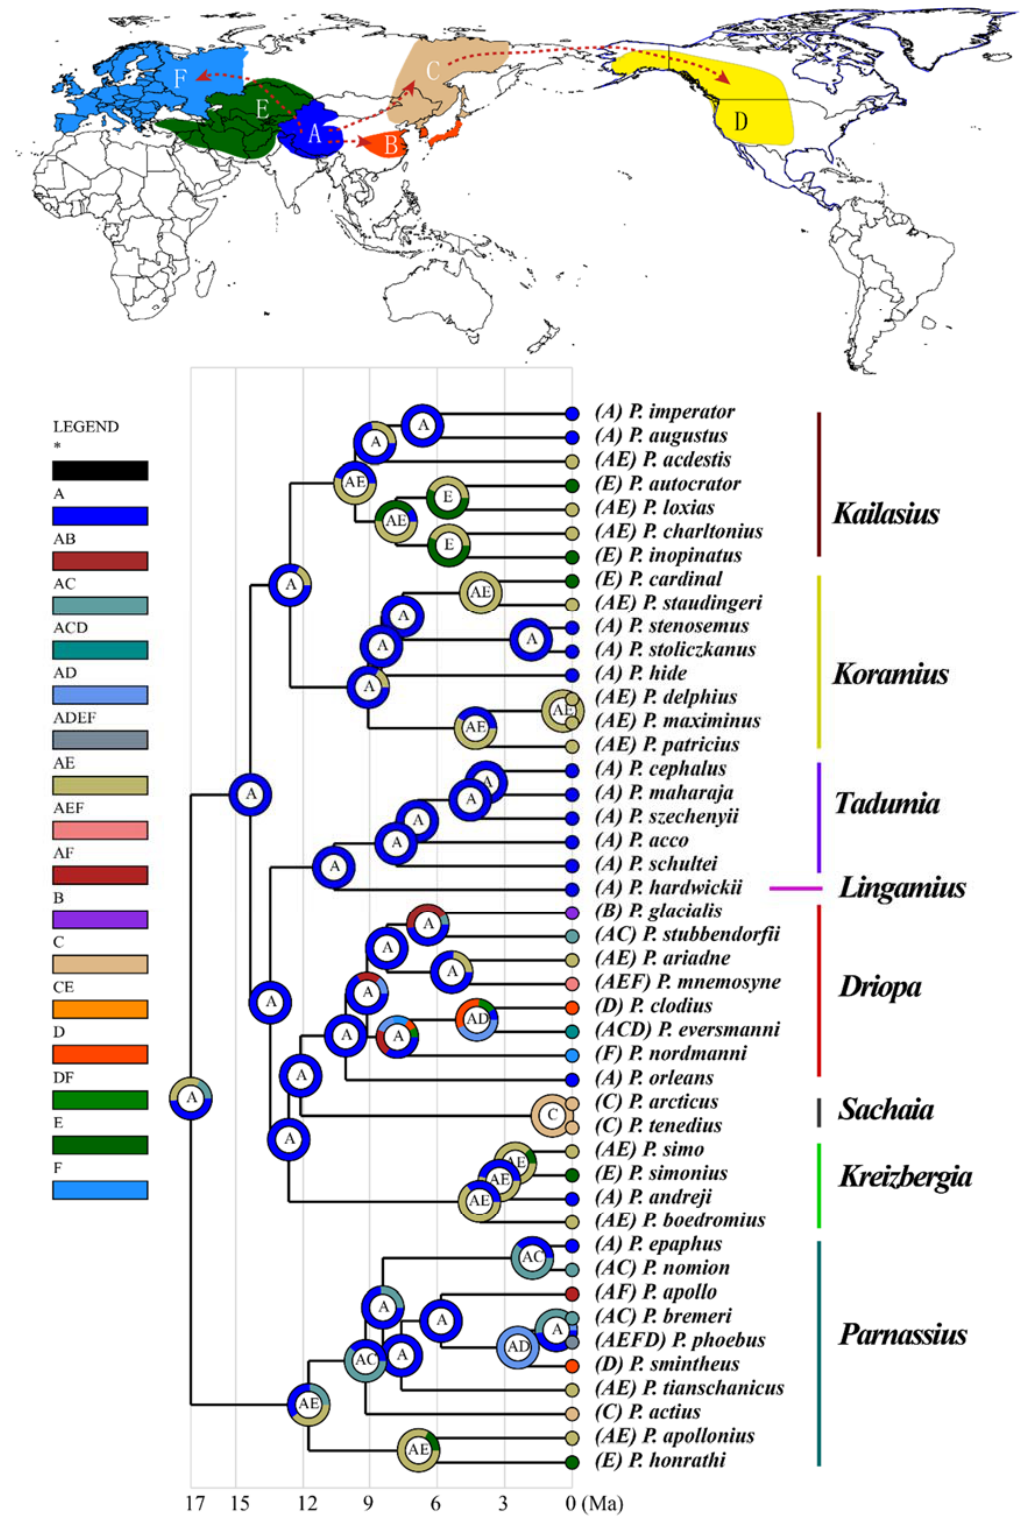
Figure 6. Time tree and ancestral area reconstruction of Parnassius based on mitochondrial DNA. Ancestral area assignments at the nodes represent the marginal probabilities of alternative ancestral distributions obtained through statistical dispersal–extinction cladogenesis: (A) QTP and Xinjiang; (B) Central East China, Korea, and Japan; (C) Northeast Asia; (D) North America; (E) Central and Western Asia; and (F) Europe. * Indicates all regions.